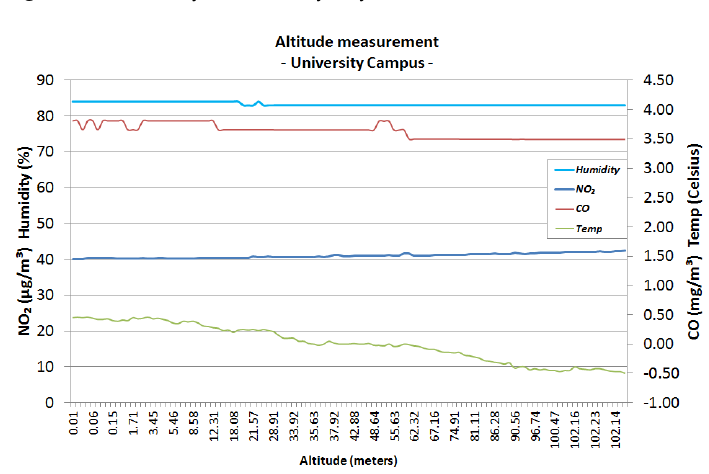
Figure 7. University area, snowy day, winter, 50 m altitude.